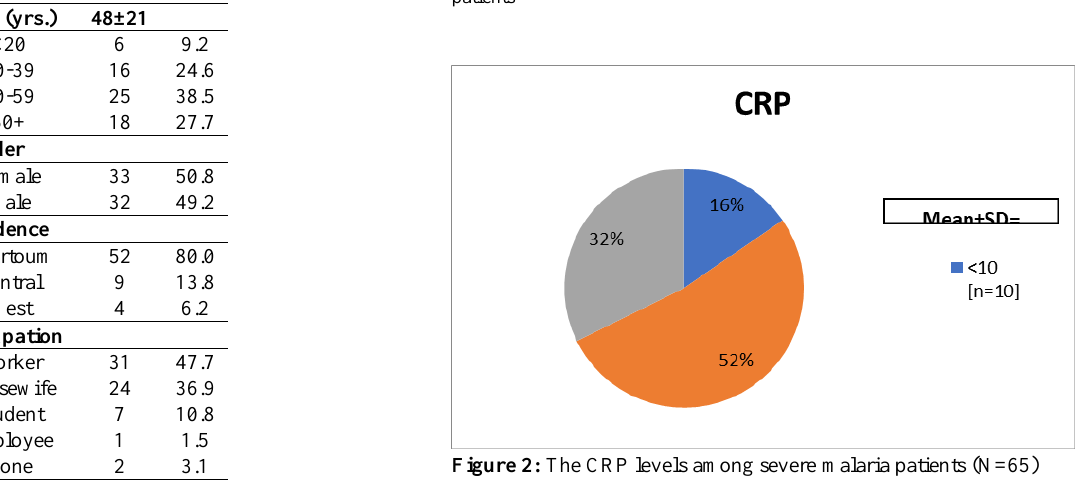
B Figure 1: The distribution of symptoms and signs among severe malaria patients